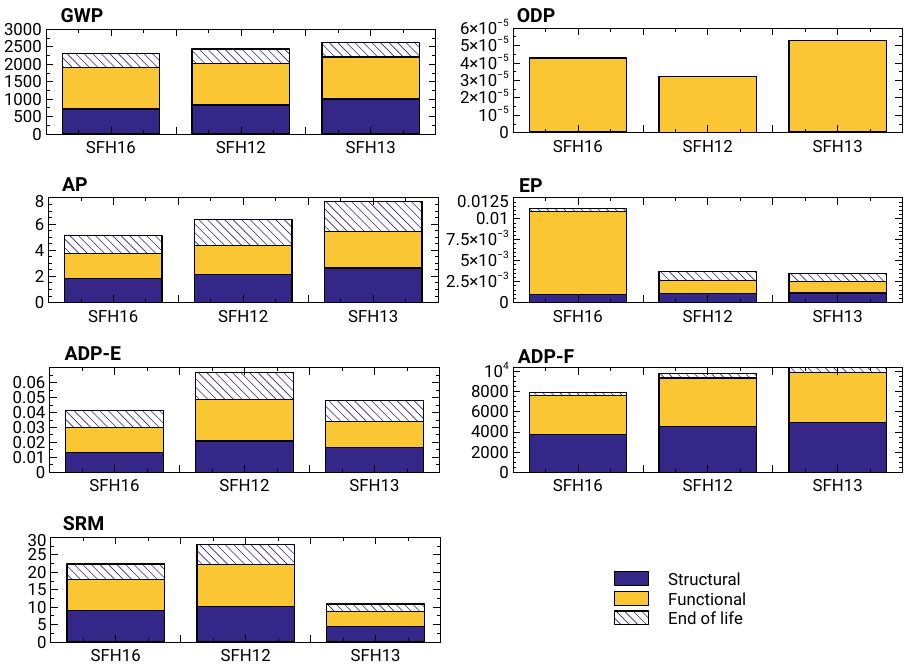
Figure 7. Overall life cycle